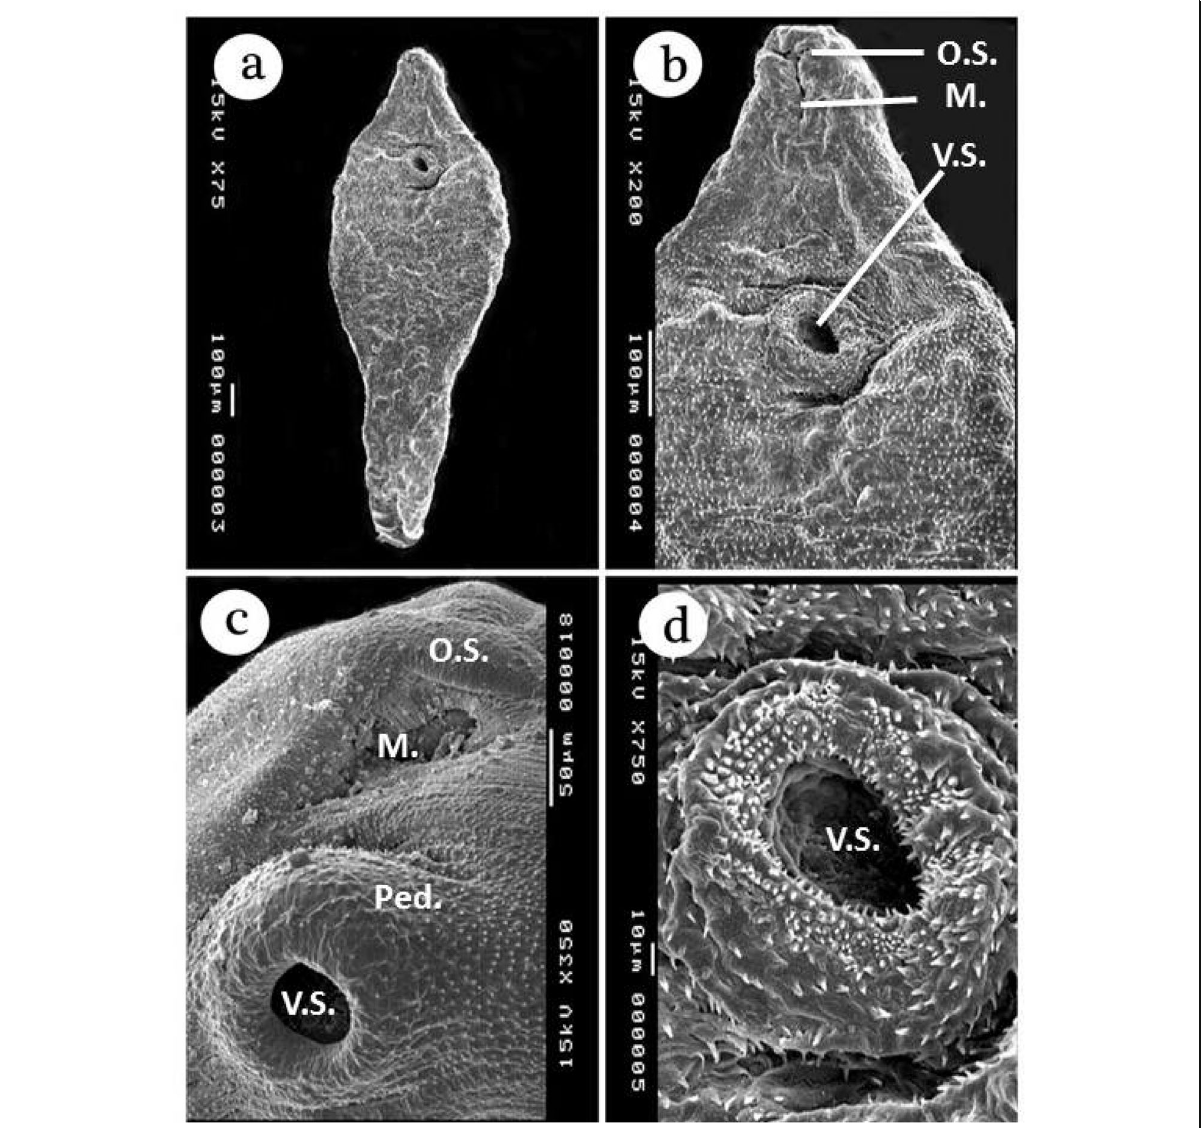
Fig. 4 Scanning electron micrographs of Mesocoelium sociale . a Shows the whole worm. b Shows the anterior end provided with oral sucker (O.S.) surrounding the mouth opening (M.) that appears as a vertical slit, sessile ventral sucker (V.S.), and tegumental spines. c Shows the muscular oral sucker (O.S.) surrounding the mouth opening (M.) that appears as deep hole and ventral sucker on very short peduncle (Ped.). d Shows magnified ventral sucker (V.S.) surrounded by dense tegumental